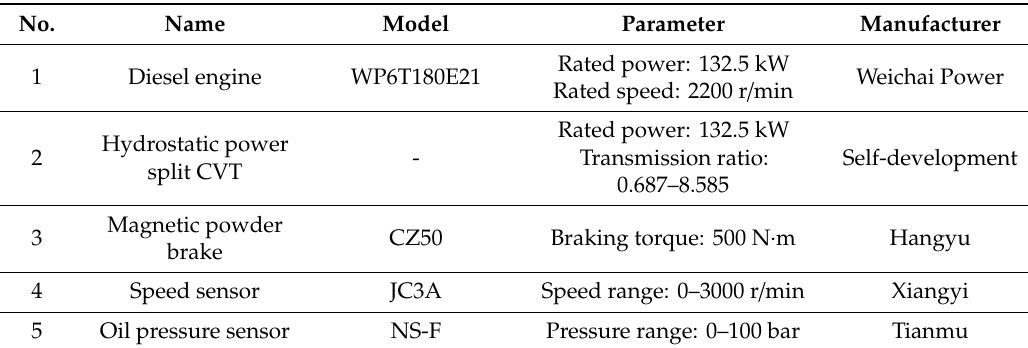
Figure 9. Test bench of the power shift for the hydrostatic power split CVT. Table 1. Test equipment.